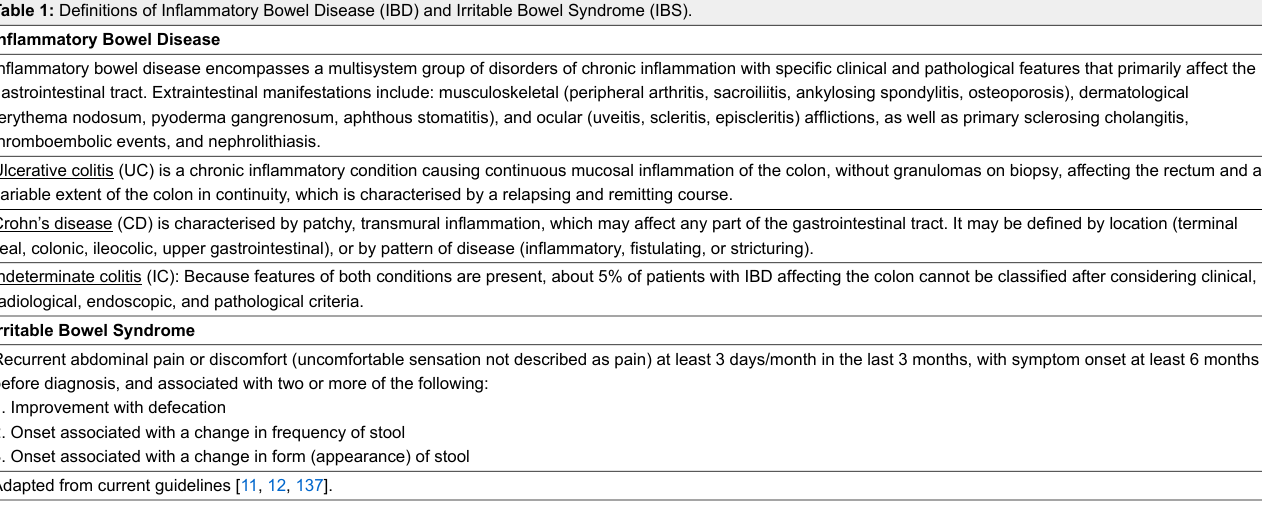
Table 1: Definitions of Inflammatory Bowel Disease (IBD) and Irritable Bowel Syndrome (IBS). Inflammatory Bowel